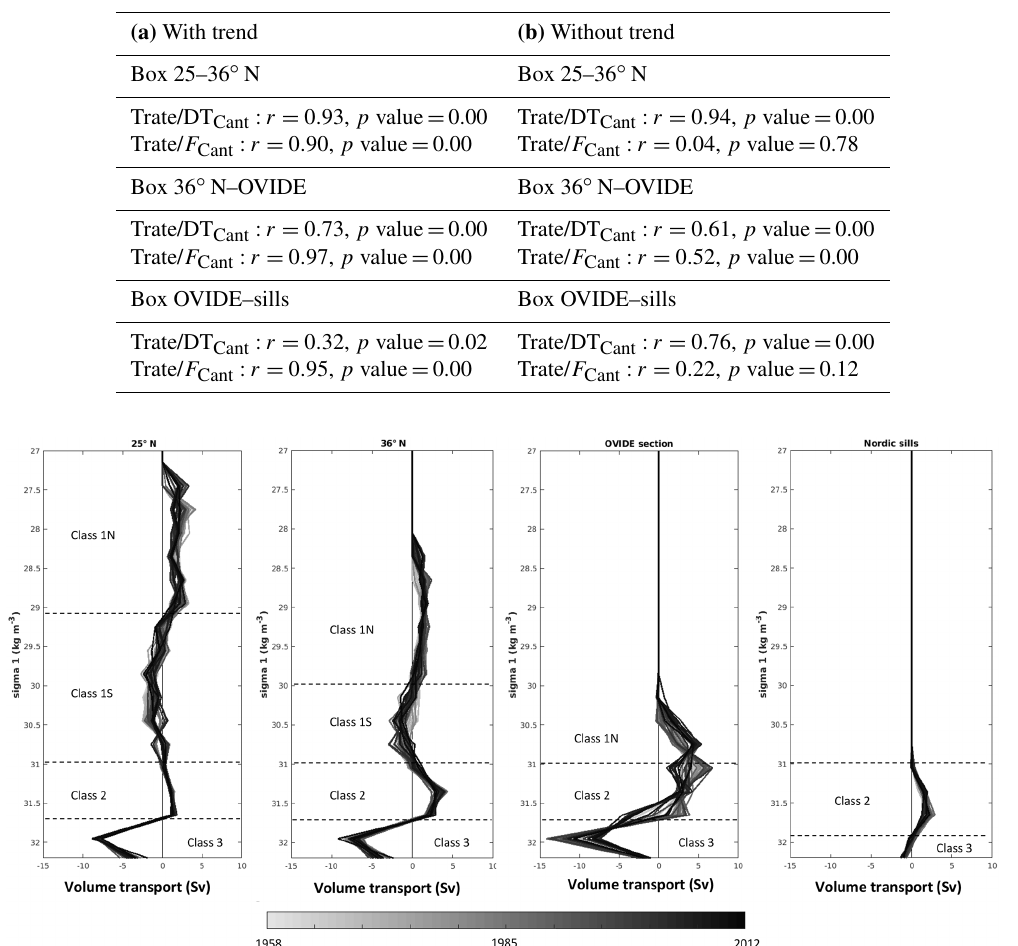
Table 6. Correlation coefficient ( r ) and p value between the time rate of change (Trate) of Cant storage, the divergence of Cant trans- port (DT Cant ) and air–sea Cant flux ( F Cant ) for the boxes, 25 ◦ N–36 ◦ N, 36 ◦ N–OVIDE and OVIDE–sills, over the period 1959–2011. DT Cant = incoming – outgoing Cant fluxes across the boundaries of boxes. The analyses were done, with the original time series ( a with trend) and with the detrended Cant transport time series ( b without trend).